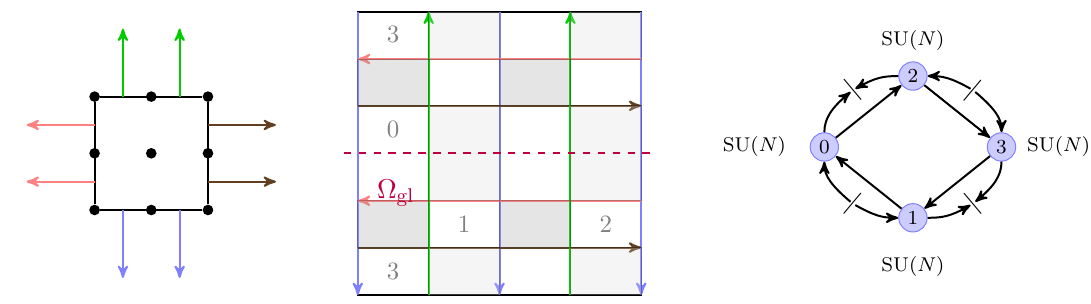
Figure 26. The model L 2 , 2 , 2 / Z 2 . On the left the toric diagram is drawn, at the center the five-brane and its glide orientifold, on the right the quiver resulting from the